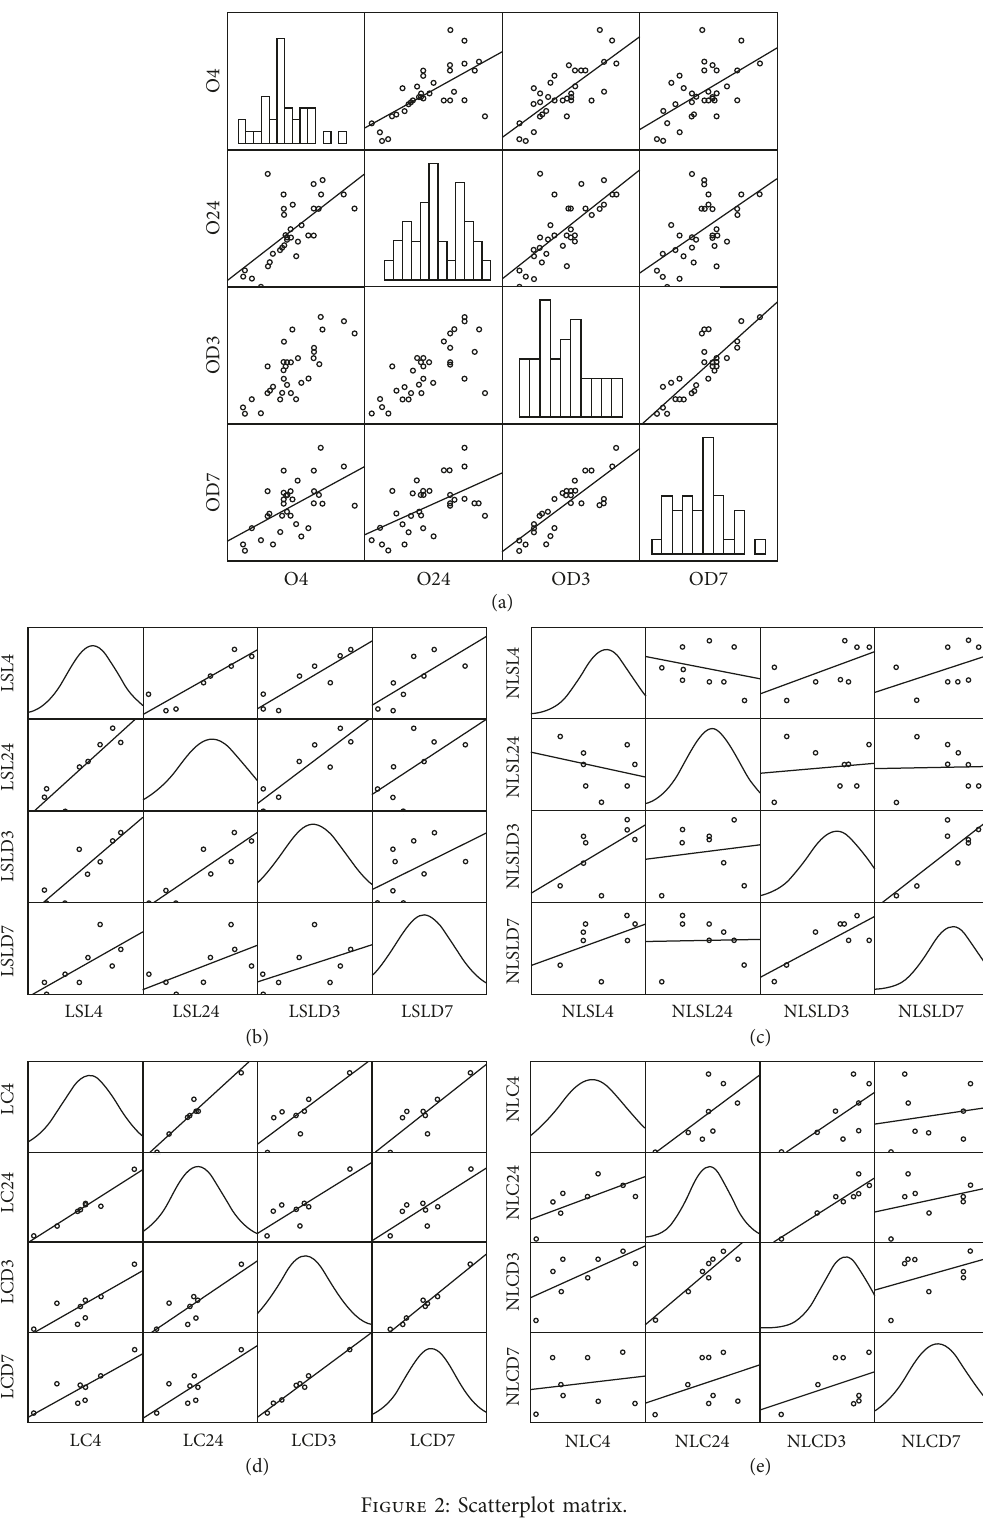
Figure 2: Scatterplot